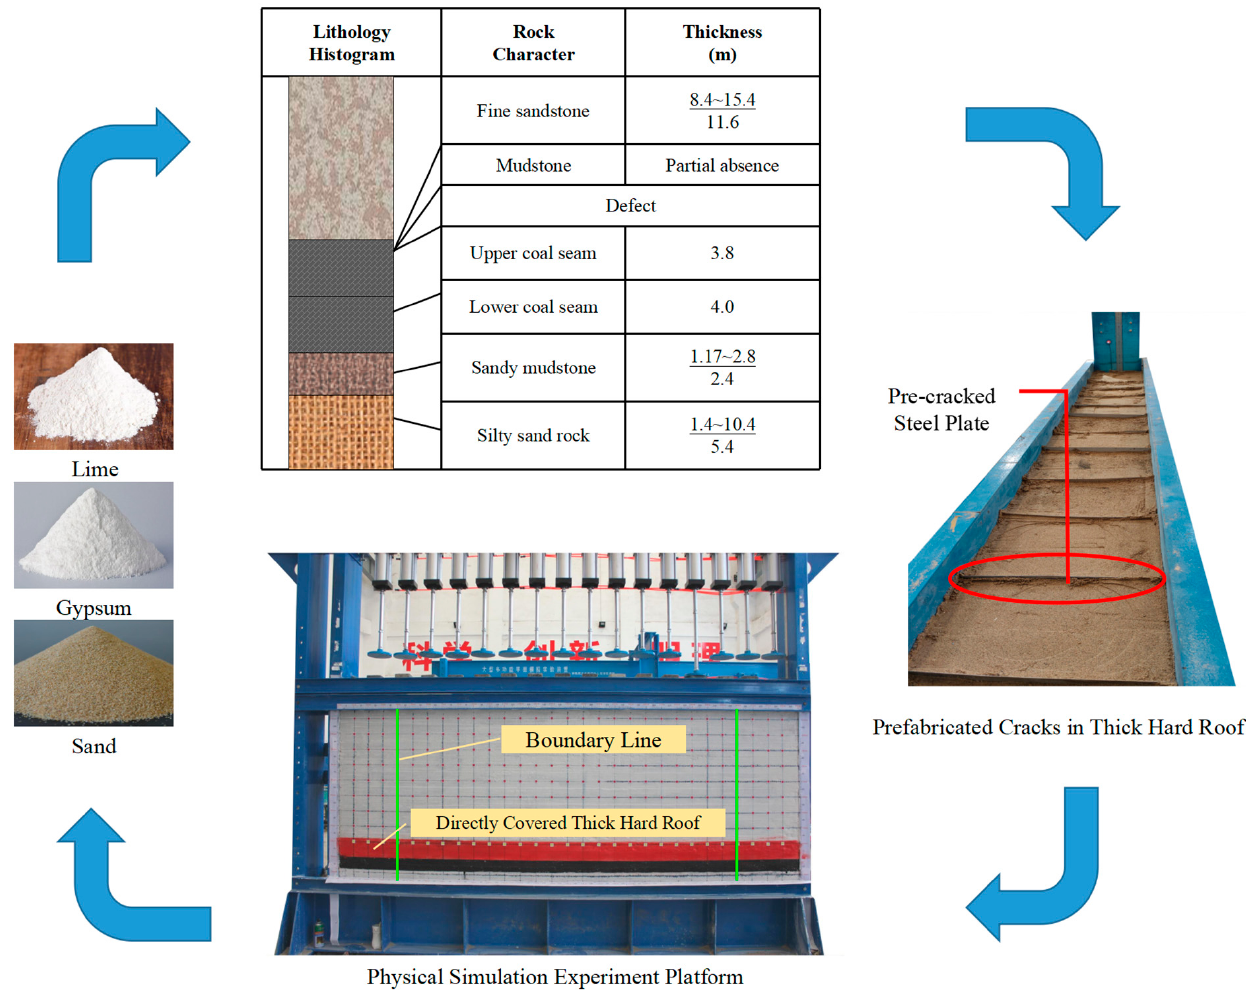
Figure 2. Similar physical experiment platform and rock stratum histogram.